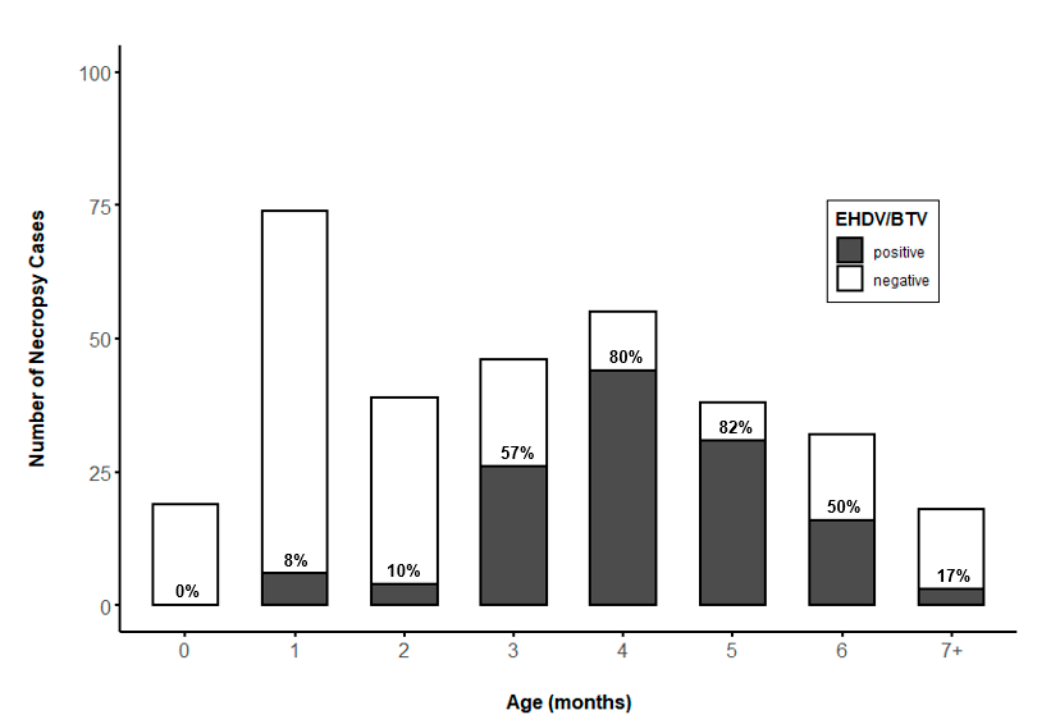
Figure 3. Age class distribution of dead white ‐ tailed deer aged 0–7+ months ( n = 321) sampled from Florida deer farms for RT ‐ qPCR testing for epizootic hemorrhagic disease virus (EHDV) and bluetongue virus (BTV). Labels within bars represent percent of WTD testing RT ‐ qPCR positive for EHDV or BTV by age (months).